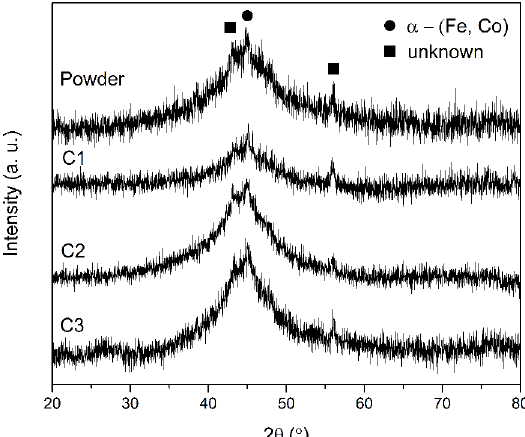
Figure 5. XRD patterns of the GAP and the consolidated